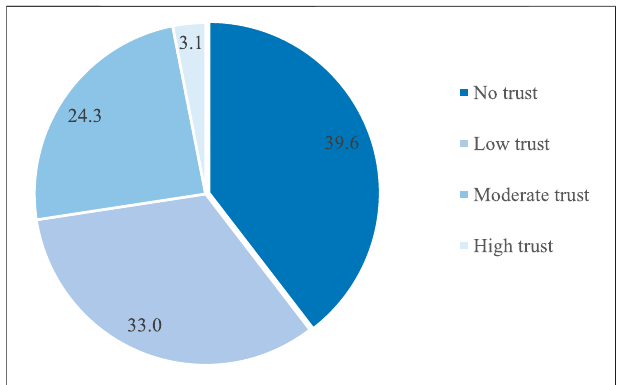
FIGURE 1 | Percentage distribution of trust score among SSA migrants in Germany ( N (cid:1)